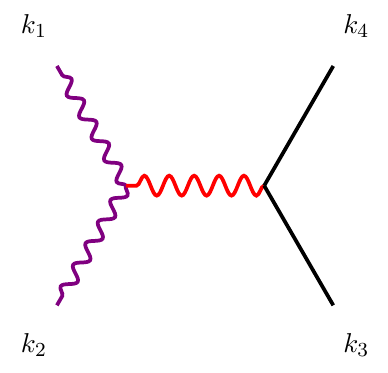
Figure 4 . ppss amplitude due to exchange of a massive spinning